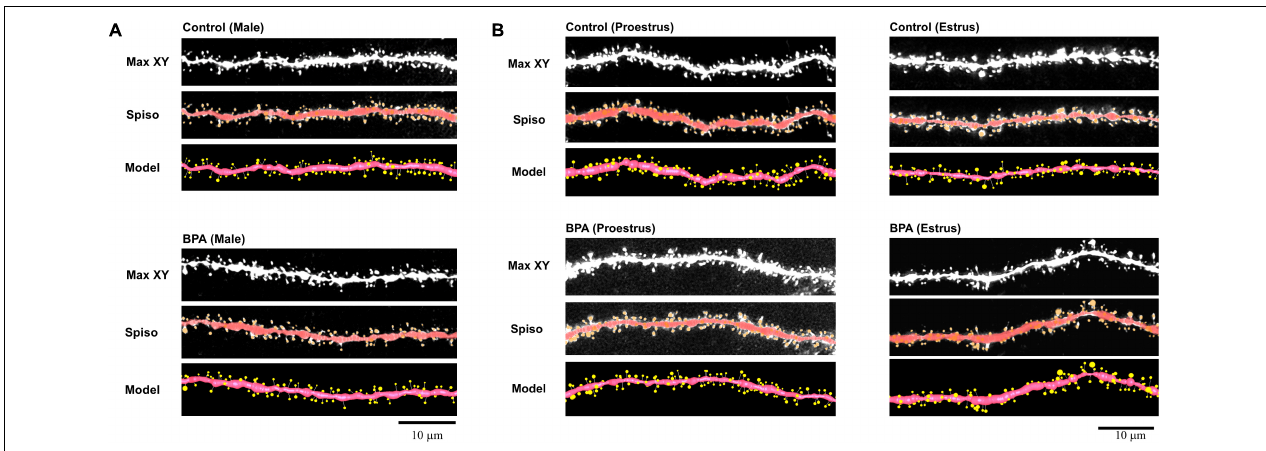
FIGURE 1 | Image analysis demonstrates the changes of the morphology and density of spines upon perinatal exposure of BPA in the hippocampus of grownup male (A) and female rats (B) . (A) Male controls (control, male) and BPA-exposed males (BPA, male) are shown. Spine images along the secondary dendrites in the stratum radiatum. Maximal intensity projections onto the XY plane from z-series confocal micrographs (Max XY). Spine images analyzed by Spiso-3D (Spiso) and three-dimensional model illustration (Model). (B) Female controls at proestrus (control, proestrus), BPA-exposed females at proestrus (BPA, proestrus), female controls at estrus (control, estrus) and BPA-exposed females at estrus (BPA, estrus) are shown. Spine images along the secondary dendrites in the stratum radiatum. Maximal intensity projections onto the XY plane from z-series confocal micrographs (Max XY). Spine images analyzed by Spiso-3D (Spiso) and three-dimensional model illustration (Model). Scale bar = 10 µ